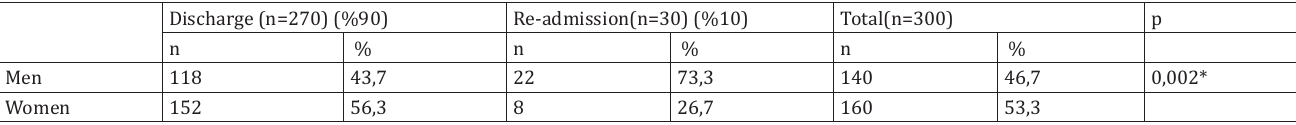
Evaluation of the study groups in terms of